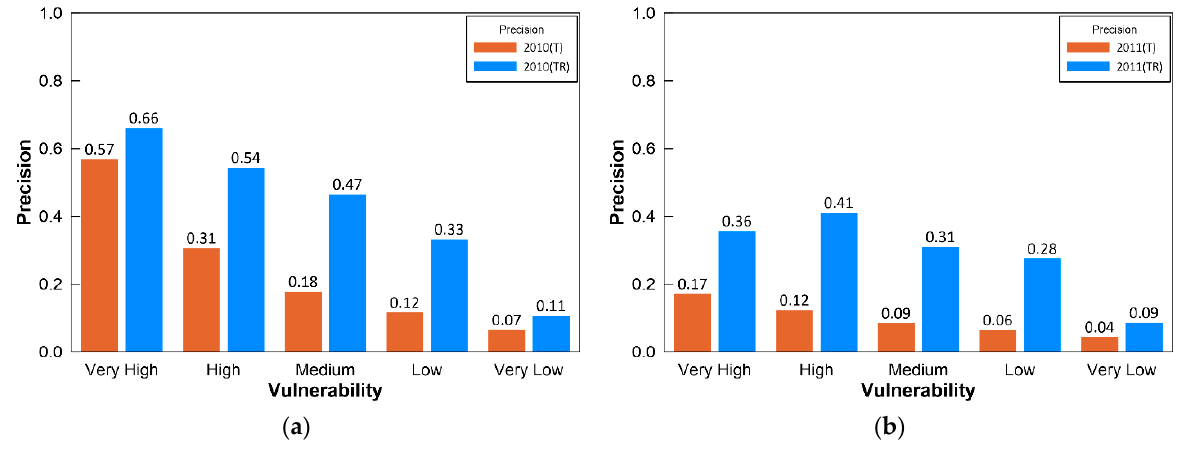
Figure 14. Proportion of flood occurrence in vulnerable areas for performance evaluation: ( a ) September 2010; ( b ) July 2011.